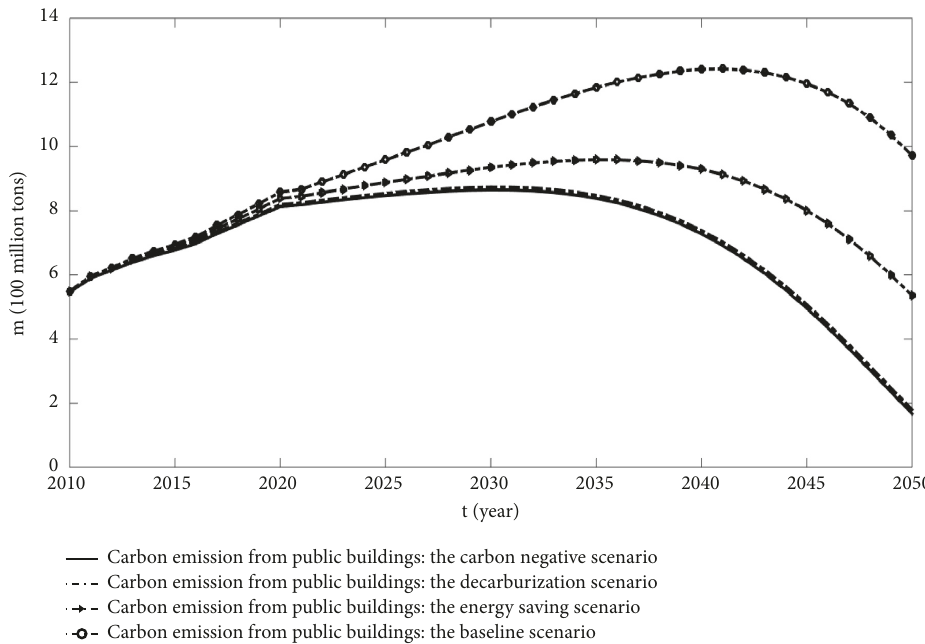
Figure 4: Comparison of predicted carbon emission values of public buildings under four scenarios. Table 5: Carbon emission scenario analysis results of public